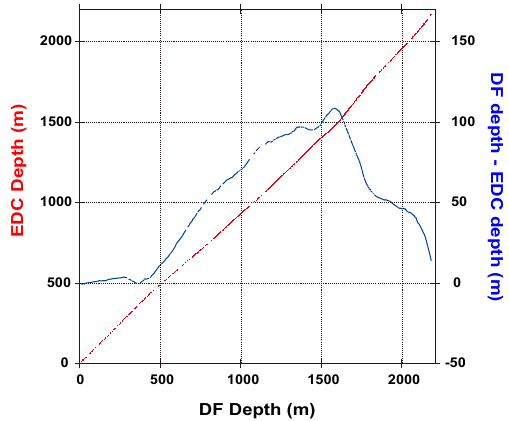
Figure B1. Result of the volcanic synchronization: DF depth–EDC depth diagram (red) and DF depth–EDC depth difference (blue).